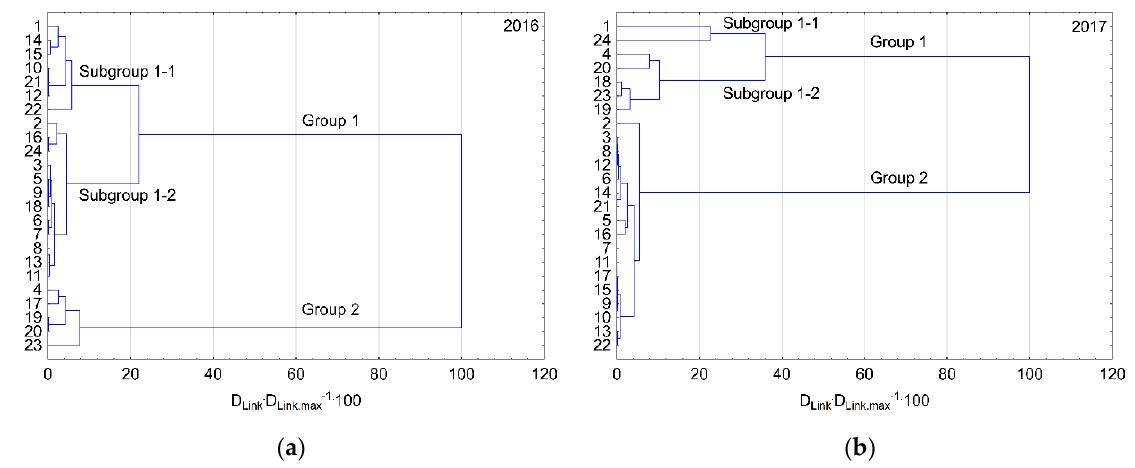
Figure 11. Division of sample collection stations into groups as a result of cluster analysis: in 2016 ( a ) and 2017 ( b ).